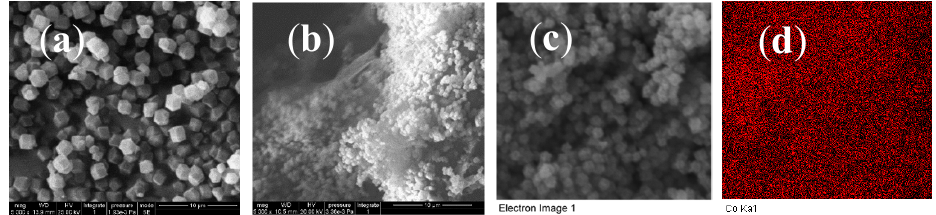
Figure 2. SEM images of ( a ) ZIF-67 and ( b ) ZFP ( c ) selected area and ( d ) EDS Co elemental mapping in ZFP.